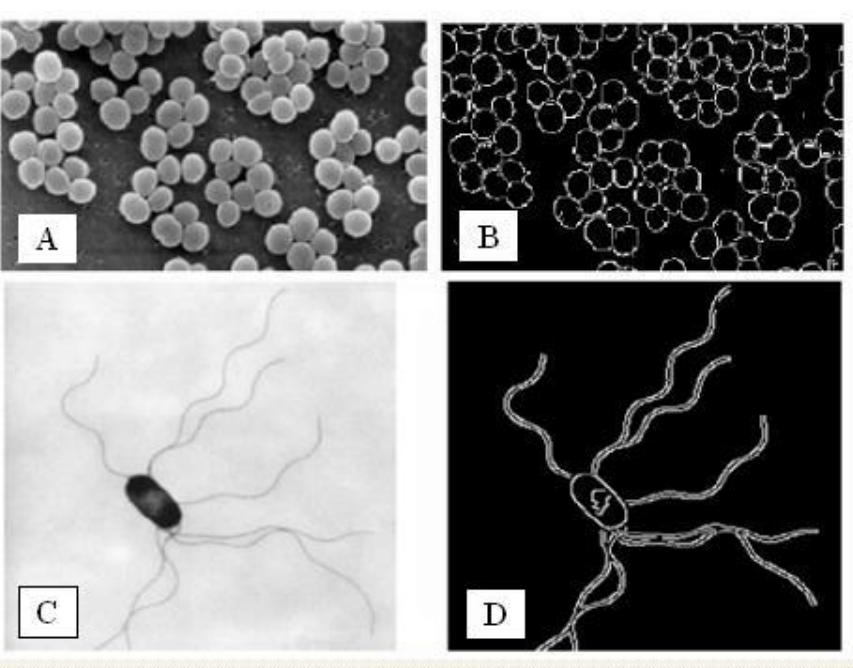
Figure 7. Shape enhancement with Sobel Convolution Edge Detection algorithm. ( A ) An original unprocessed Staphylococcus Epidermis image [23] ( B ) Image A processed with Edge Detection. ( C ) An original unprocessed [23] ( D ) Image C processed with Edge Detection.